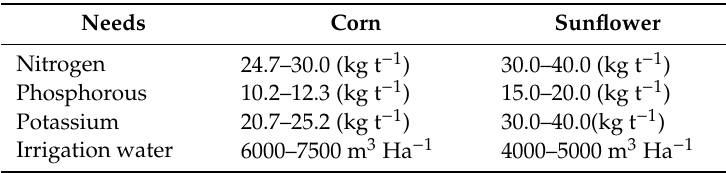
Table 1. Nutritional and irrigation needs of